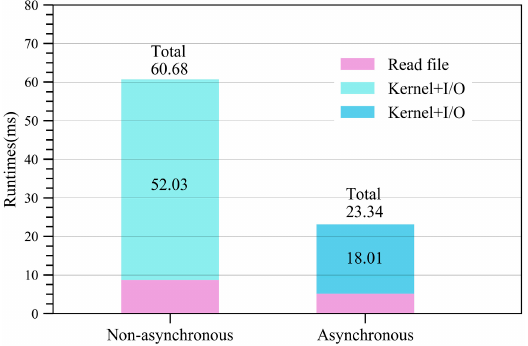
Figure 12. Description of the asynchronous data transfer (ADT) for GPU ‐ based SDCSM program.